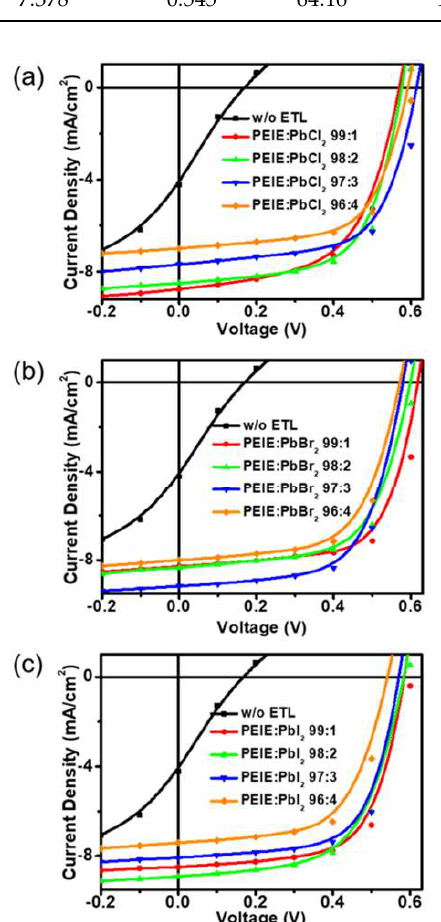
Figure 2. J-V characteristics under illumination of inverted P3HT:PC 61 BM solar cells with various electron transport layers, ( a ) PEIE:PbCl 2 , ( b ) PEIE:PbBr 2 , and ( c ) PEIE:PbI 2 , as a function of PEIE and PbX 2 ratio.